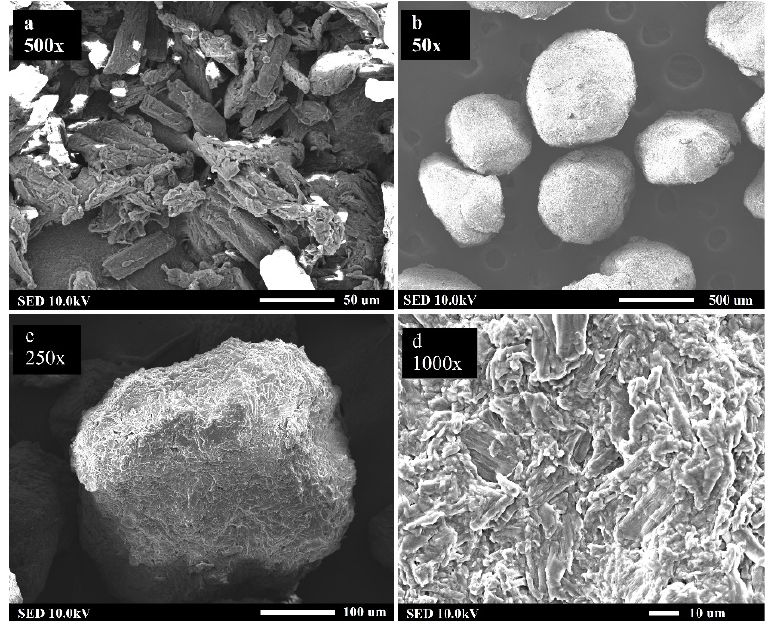
Figure 11. SED images of granules from electron microscope: ( a ) raw particles of Avicel PH101 at 500× magnification, ( b ) granules produced at L/S ≈ 1.0 and 700 rpm impeller speed at 50× magnifi- cation, ( c ) surface of granule at 250× magnification, ( d ) detail of granule surface at 1000× magnifica- tion.